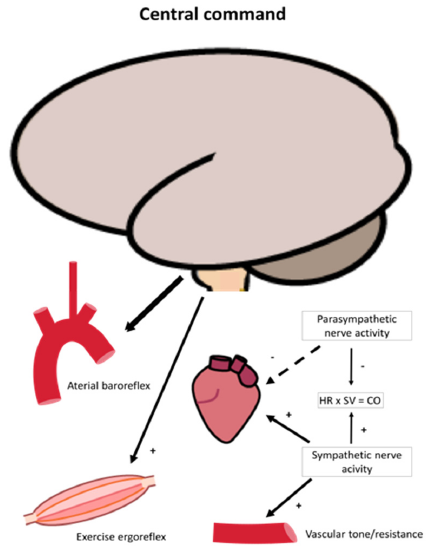
Figure 3. An illustration of neural regulation of cardiovascular control during exercise. Neural command originates from the brain and reset blood pressure and heart rate through arterial baroreflex and act through ergoreflex that in conjunction modulate sympathetic and parasympathetic nerve activity during exercise. Parasympathetic drive is diminished resulting in higher sympathetic activity, increasing heart rate and arterial contractility and resistance/capacitance of the vessels. As a result, heart rate (HR) and stroke volume (SV), and thus cardiac output increases.